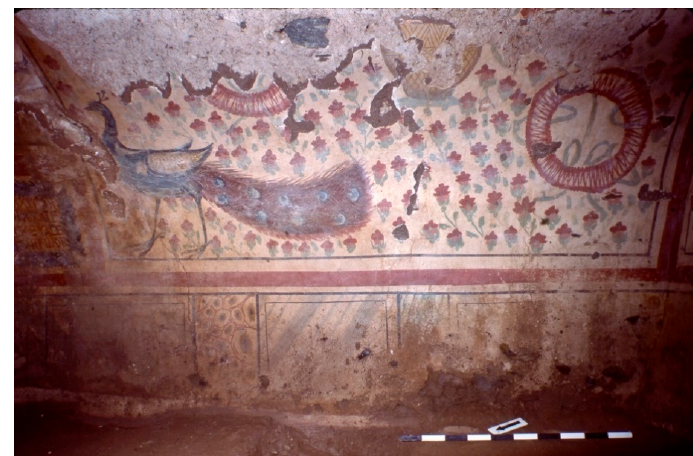
Figure 7. Sardis, Tomb of Chrysanthios (Tomb 76.1, Appendix A.1), east wall. © Archaeological